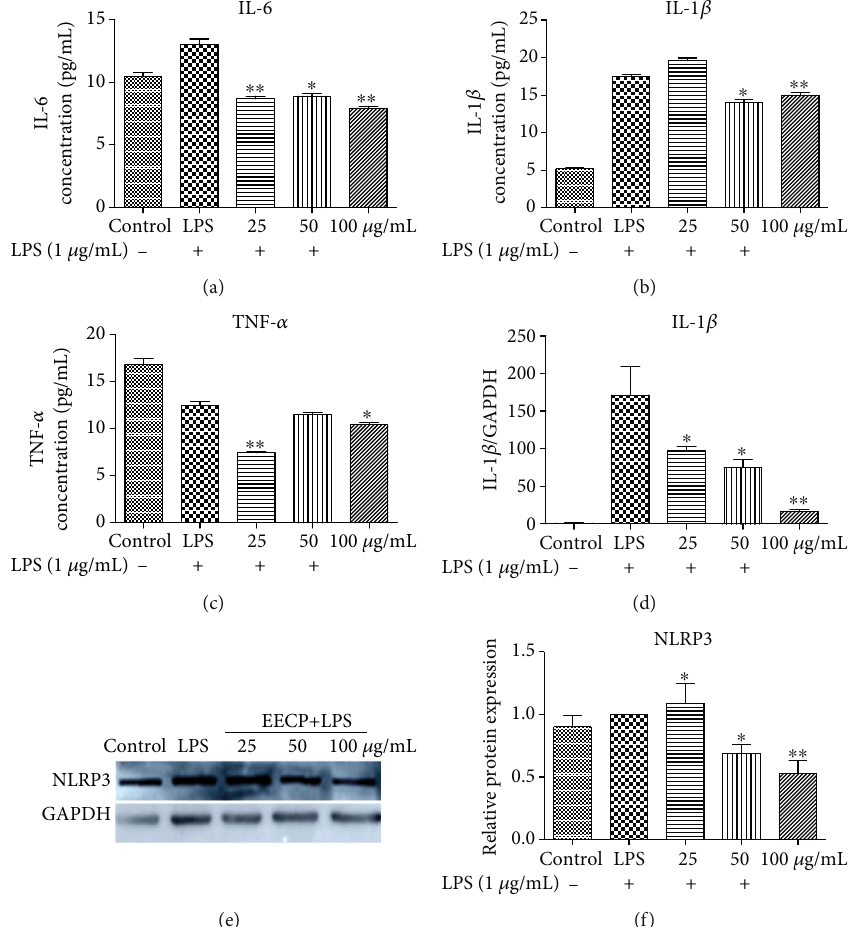
Figure 3: EECP suppressed the levels of in fl ammatory mediators in MDA-MB-231 cells stimulated with LPS. (a) – (c) EECP inhibited the levels of IL-6, IL-1 β , and TNF- α in MDA-MB-231 cells stimulated with LPS, as detected by ELISA kits. (d) EECP inhibited the levels of IL-1 β compared with the LPS group, as detected by RT-PCR. (e) EECP inhibited the levels of NLRP3 compared with the LPS group, as detected by Western blotting. (f) Quanti fi cation of the relative expression level of NLRP3 in MDA-MB-231 cells. Values represent the mean ± SEM from three independent experiments ( ∗ P < 0 : 05 , ∗∗ P < 0 : 01 vs. control, n = 3